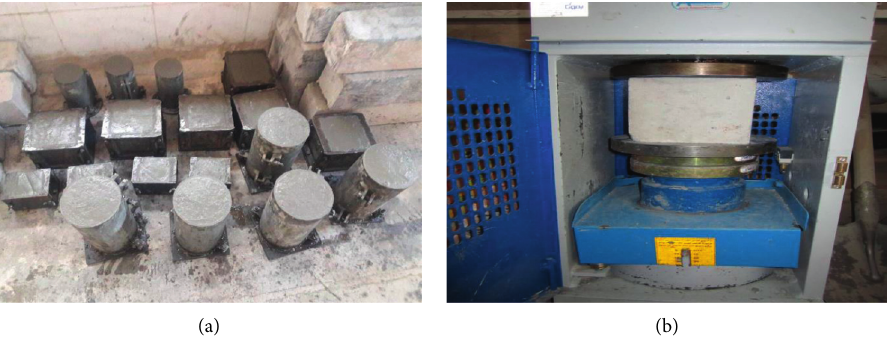
Figure 3: Compressive strengths specimens test. (a) Prepared samples. (b) Compressive strengths test